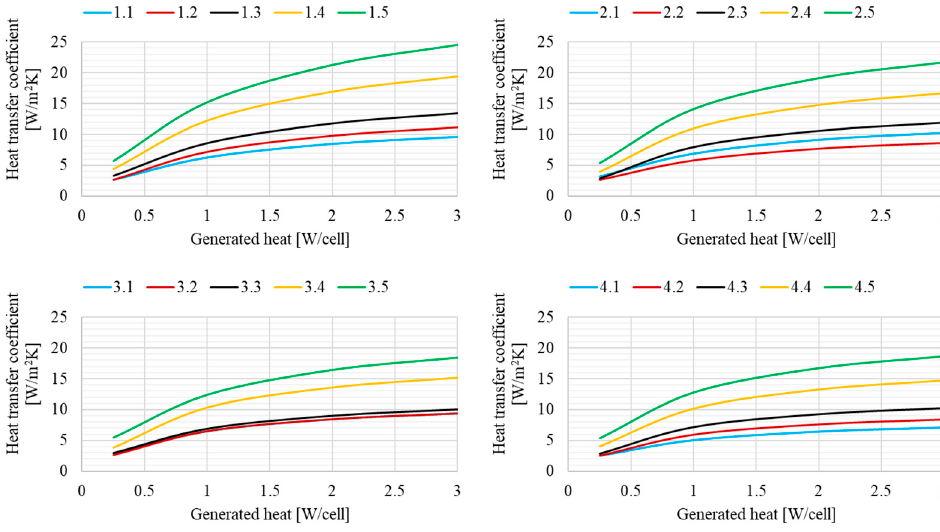
Figure 9. Heat transfer coefficient variation with generated heat obtained from CFD simulations.